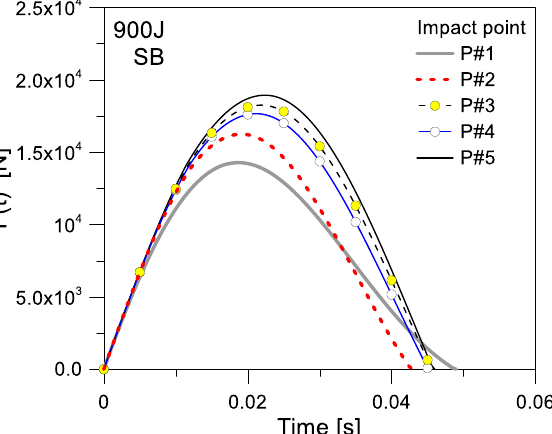
Figure 12. Example of input time histories for the curtain wall under SB, at different impact points ( E imp = 900 J).